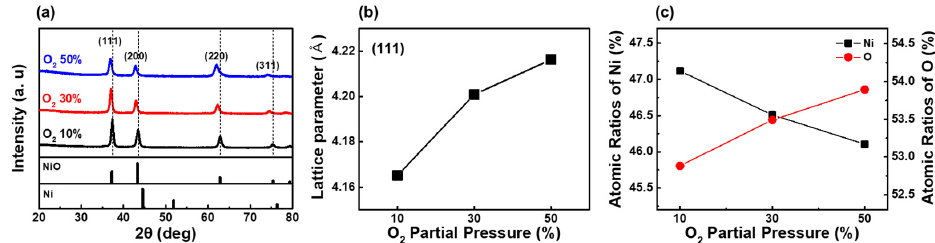
Figure 1. ( a ) XRD patterns of Ni 1 − x O films deposited with various oxygen partial pressures. ( b ) Lat- tice constant of Ni 1 − x O, estimated from (111) peak position, as a function of oxygen partial pressures. ( c ) Nickel and oxygen composition in Ni 1 − x O by AES.